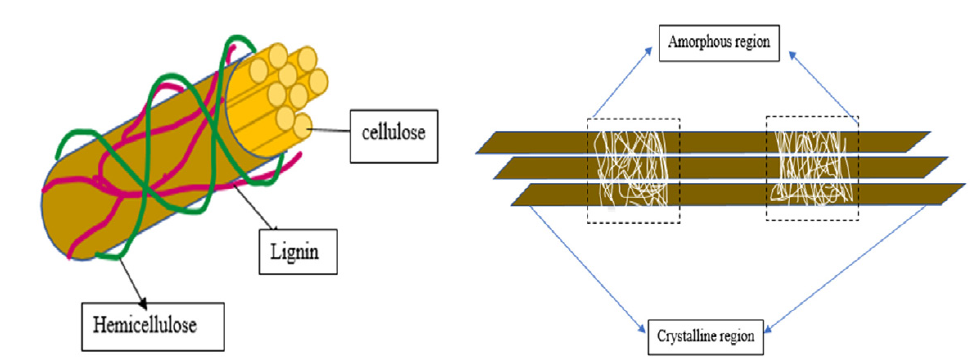
Fig. 1. The binding pattern and structure of lignocellulosic